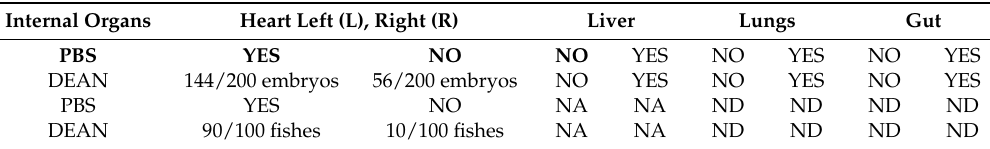
Table 2. The organ positions of the chick and zebrafish embryos were scored and summarized in the table. ND, not determined; NA, not applicable.